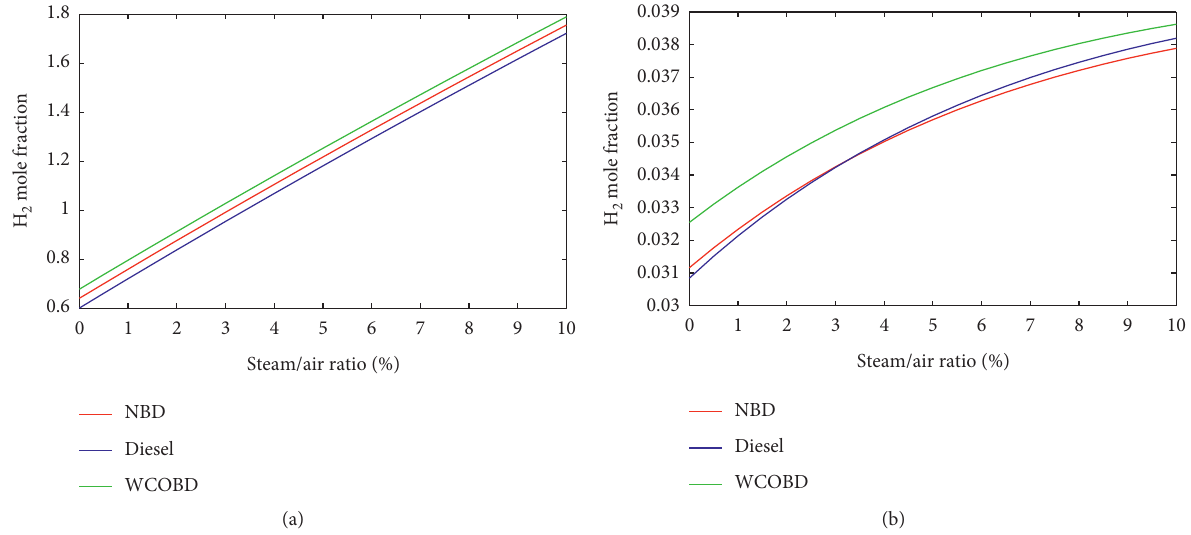
Figure 6: Variation of H 2 equilibrium mole fractions with steam injection